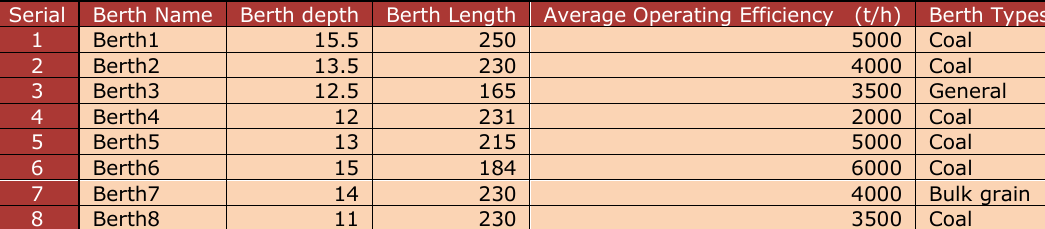
Table 7. Berth data list